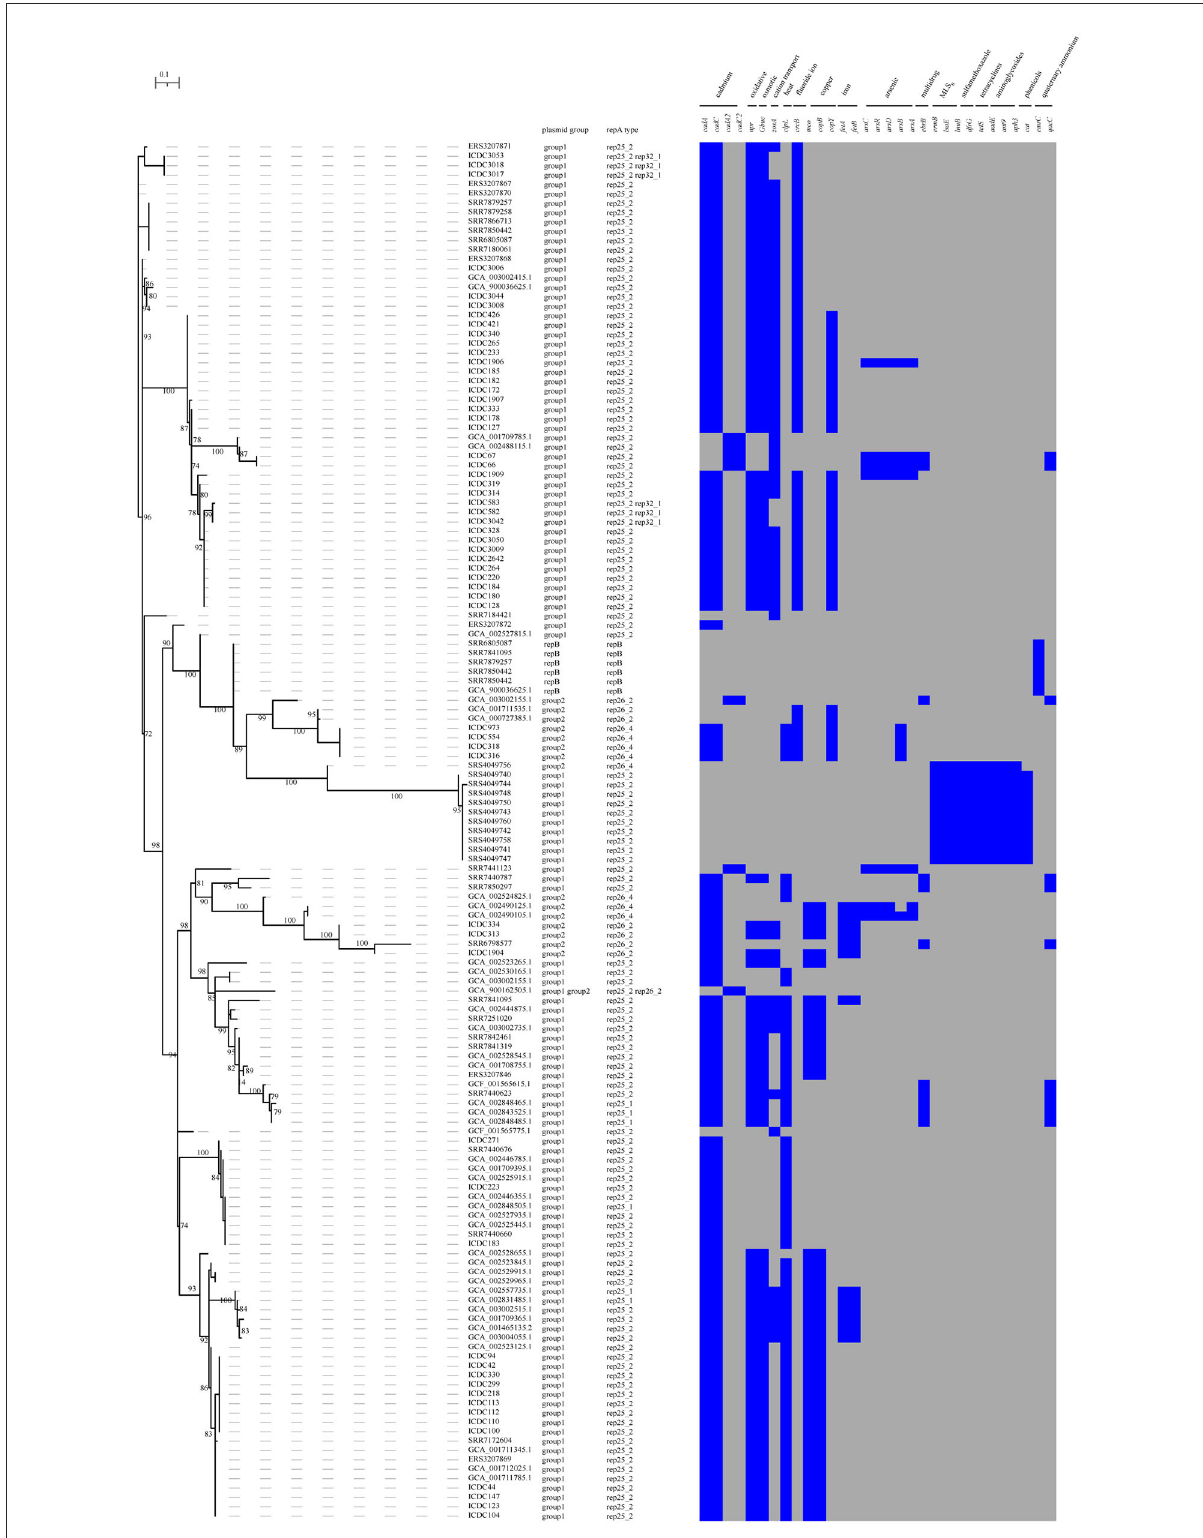
FIGURE2 The presence and absence of accessory genes tree of the plasmids. The accessory_binary_genes tree of the putative plasmid was created by Roary. Heatmap showing the presence or absence of the stress resistance genes in the plasmids. Presence and absence genes are marked in blue and gray